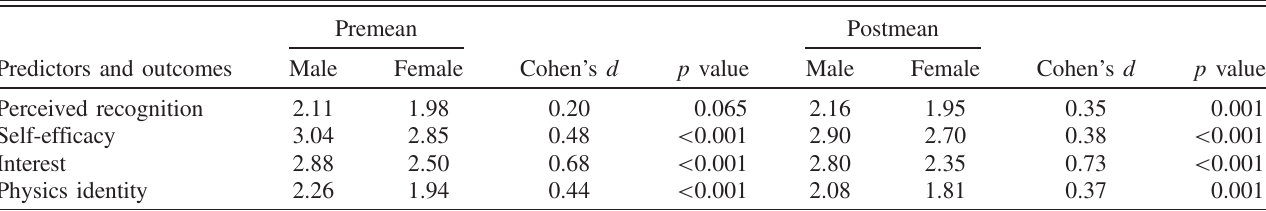
TABLE VI. Mean physics 1 pre- and postpredictor and outcome values by gender as well as statistical significance ( p values) and effect sizes (Cohen ’ s d ) by gender for 260 women and 126 men. All p values < 0 . 001 . Premean Postmean Predictors and outcomes Male Female Cohen ’ s d p value p value Perceived recognition Self-efficacy Interest